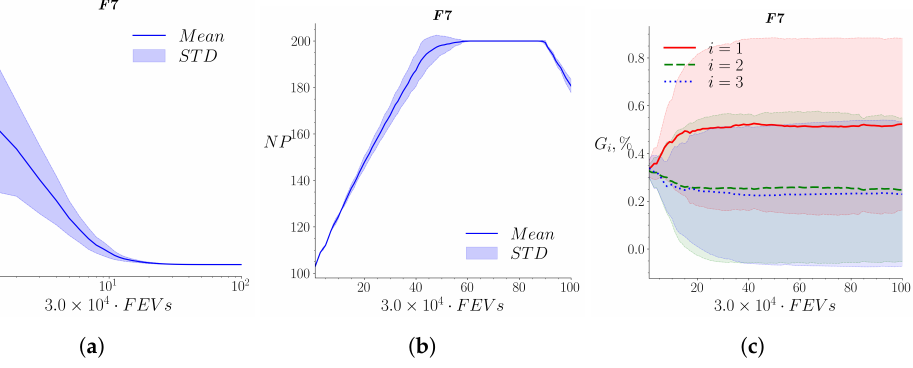
Figure A7. The dynamics of COSACC-LS1 on the F7 problem: ( a ) Convergence; ( b ) Population size; ( c ) Redistribution of